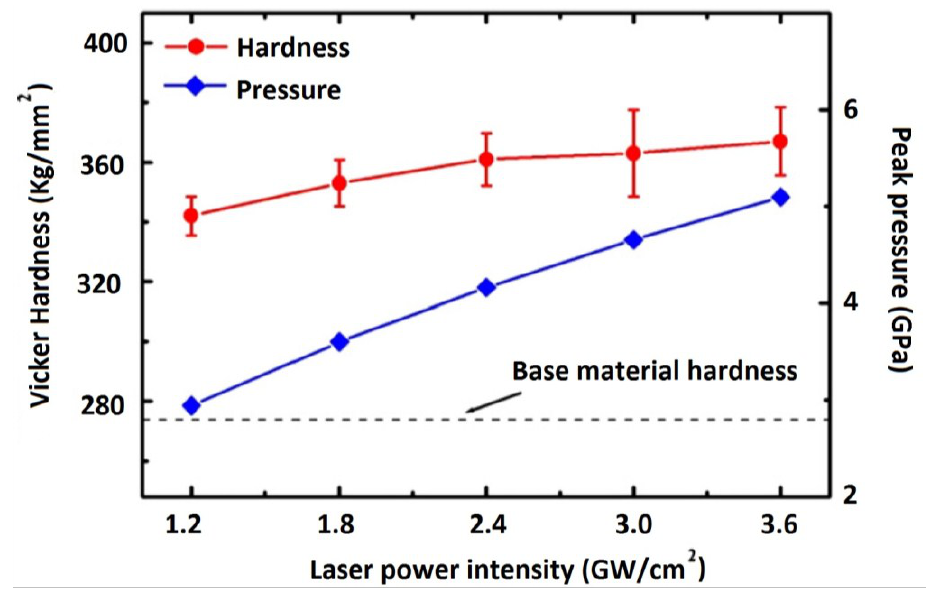
Figure 16. Surface hardness after warm laser shock peening (WLSP) at various laser power intensities and the corresponding peak plasma pressure